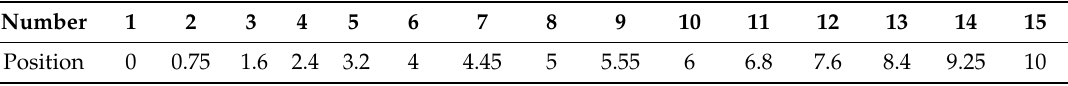
Table 1. Array element positions of scalar hydrophone array optimized by compressed sensing (CS).